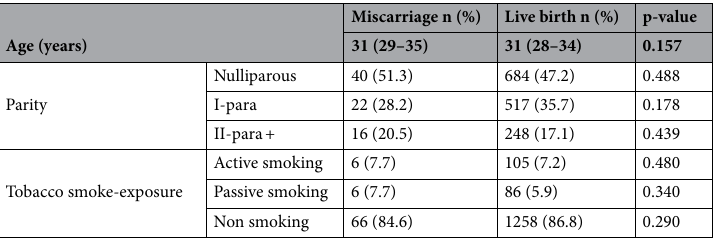
Miscarriage, n = 78